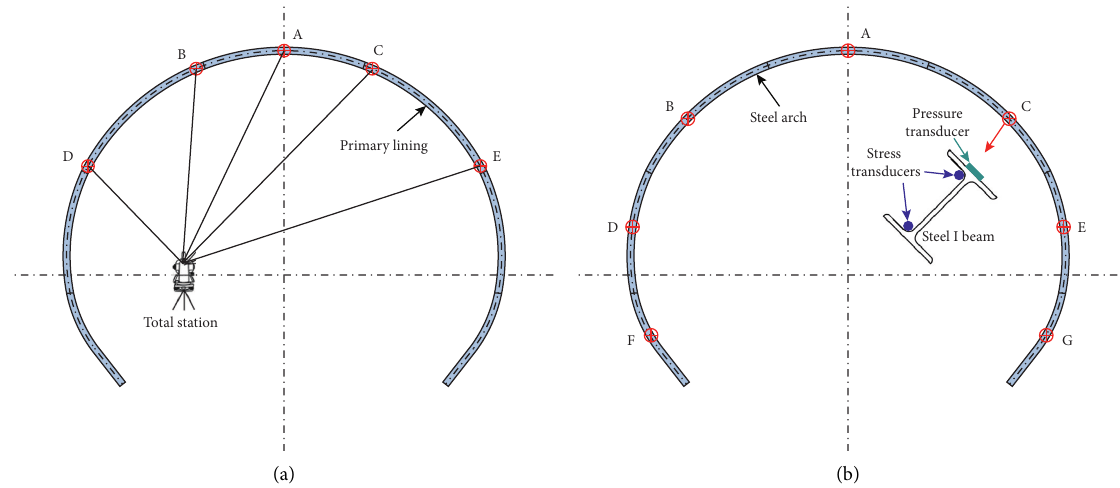
Figure 6: Monitoring points of (a) deformation of the primary lining and (b) surrounding rock pressure and steel arch